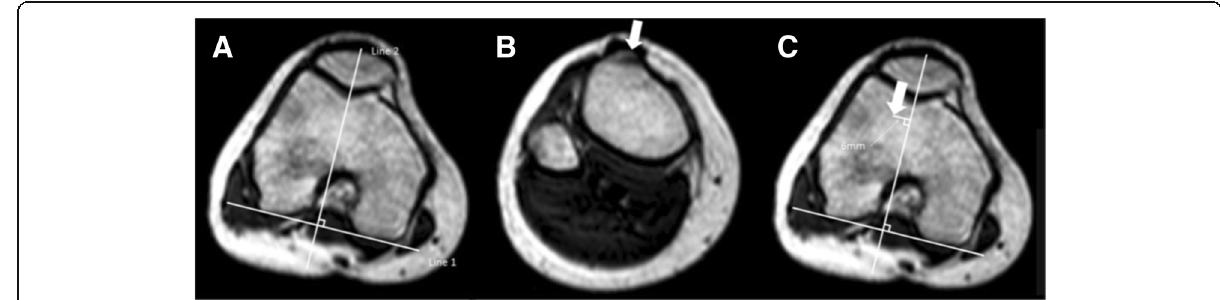
Fig. 1 TT-TG distance is measured using axial slices. a First tangential line to the posterior condyles is drawn (Line 1). Next a line, perpendicular to Line 1, transecting the deepest point of the bony outline of the trochlear groove. This line is drawn to the most cranial slice with complete cartilaginous coverage of the trochlea (Line 2). b The most anterior point of the tibial tuberosity is defined as reference point. Keeping the cursor steadily in locations of the reference point, the image slab is then rolled back until the previously defined Line 2 is present. c The distance between the location of the cursor and Line 2 is measured in millimeters presenting the TT-TG distance, in this case 6 mm